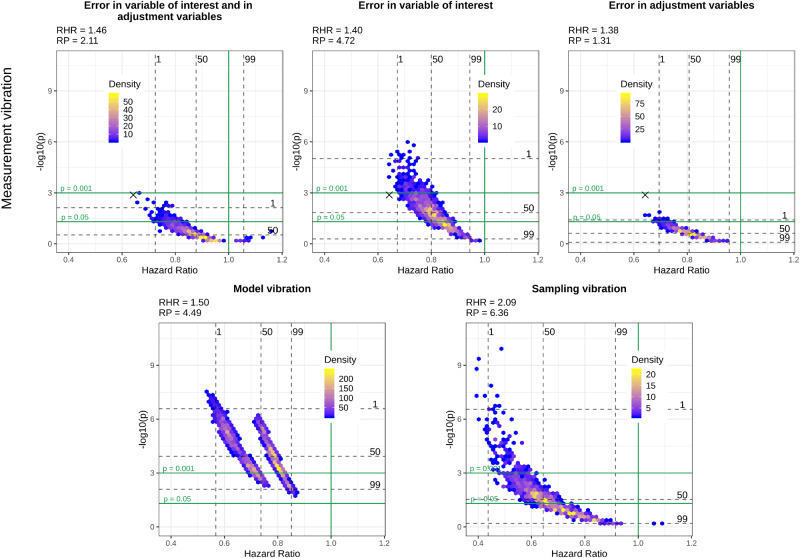
Volcano plots for different types of vibration and different scenarios of measurement vibration when thigh circumference is the variable of interest. The black cross in the top panel indicates the model without measurement error